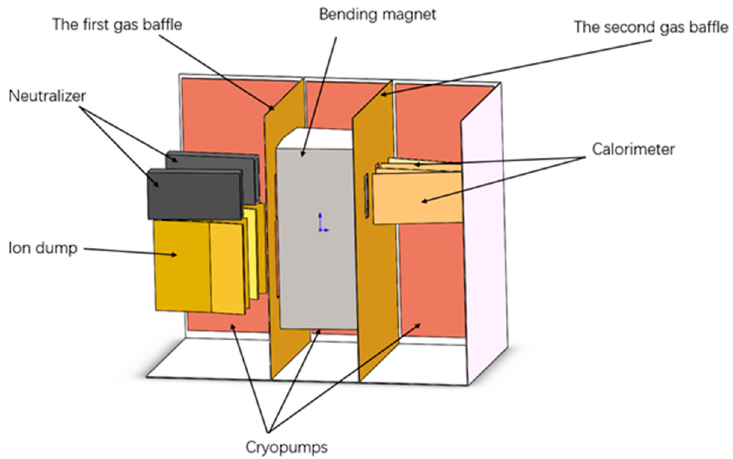
Figure 2. Three-dimensional schematic diagram of the upgraded NBI vacuum chamber and components.